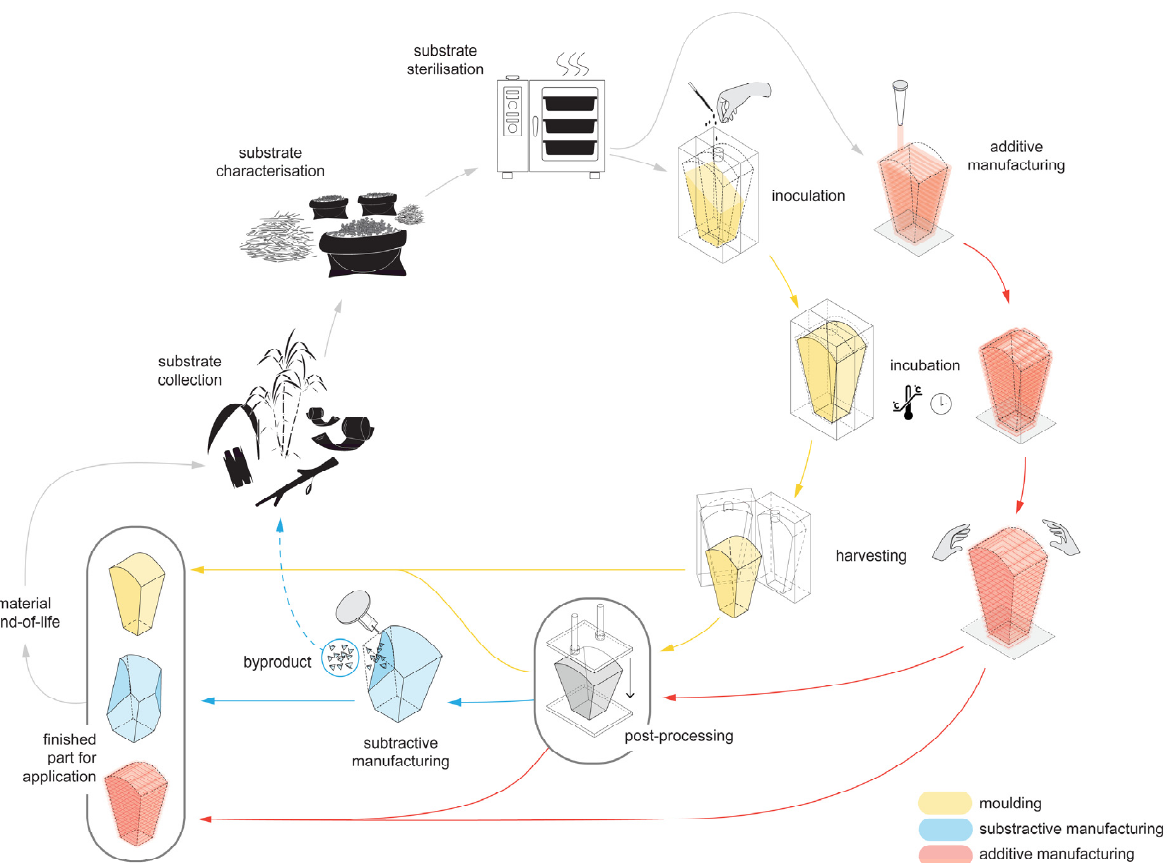
Figure 1. Circularity and workflow of current manufacturing processes applied to mycelium-based materials, adapted from [15–17].